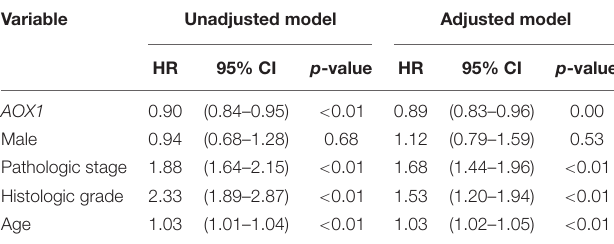
TABLE 3 | Cox regression